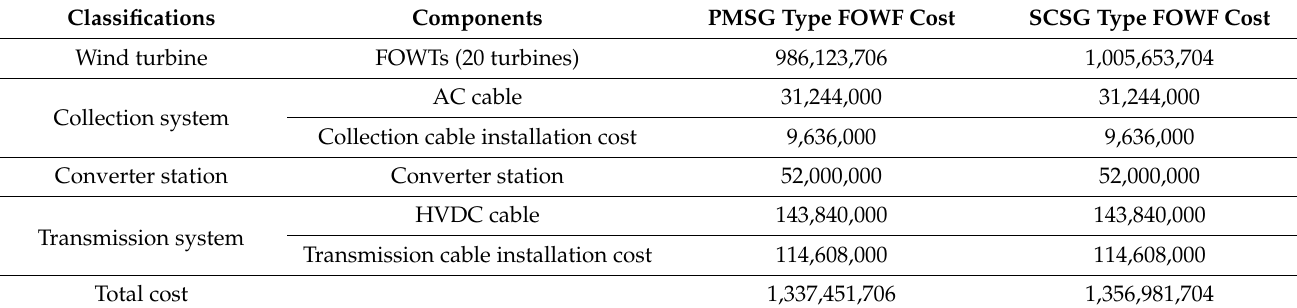
Table 11. CAPEX of the 200 MW class PMSG and SCSG types FOWFs (unit: USD).